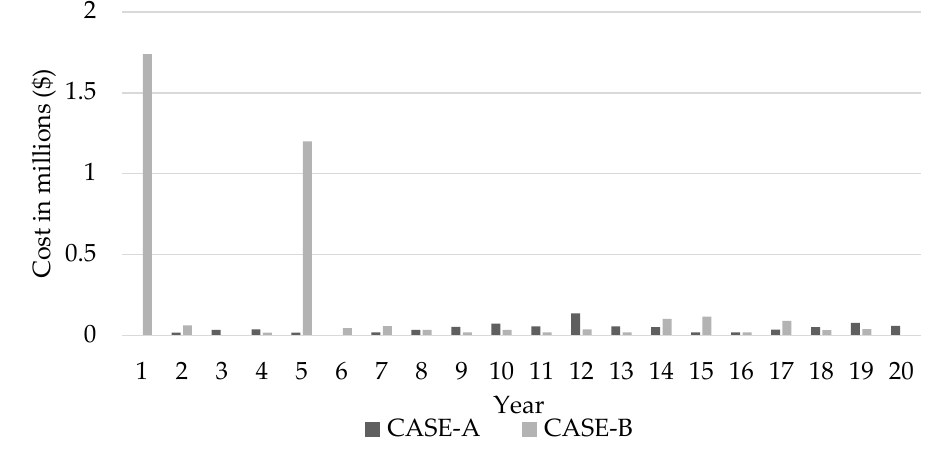
Figure 7. Annual protection equipment’s installation and upgrades cost comparison.